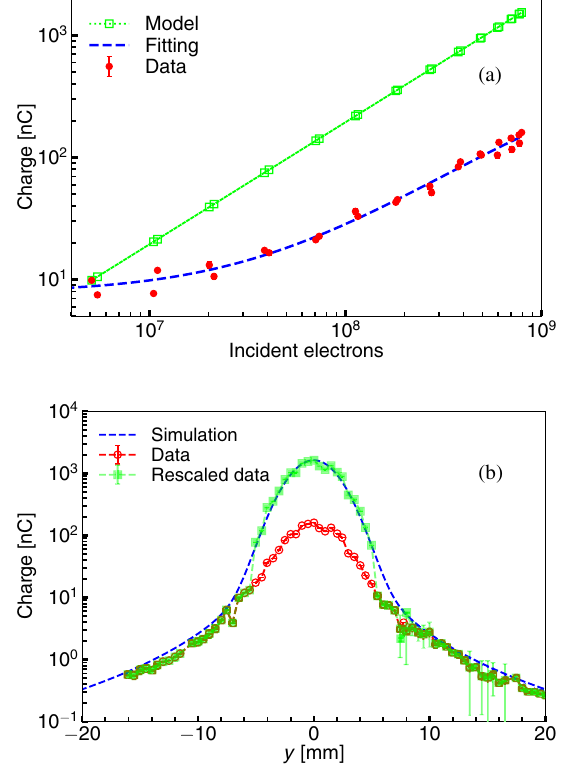
FIG. 8. Ideal and actual charge collections on the DS strip as a function of incident electron population for the evaluation of rescaling factor (a) and comparison of vertical beam profile before and after correction (b).